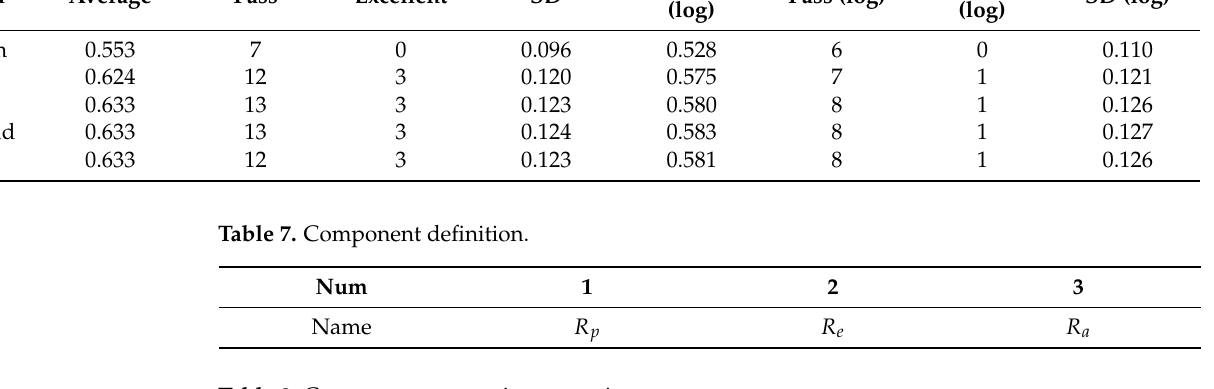
Table 8. Component comparison